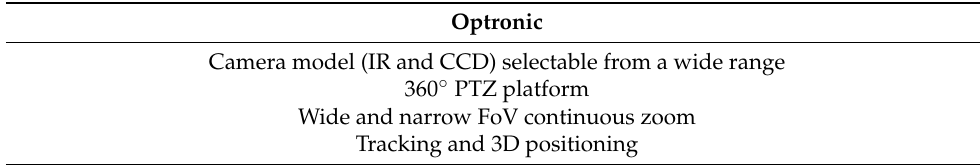
Table 11. ARMS camera specifications.